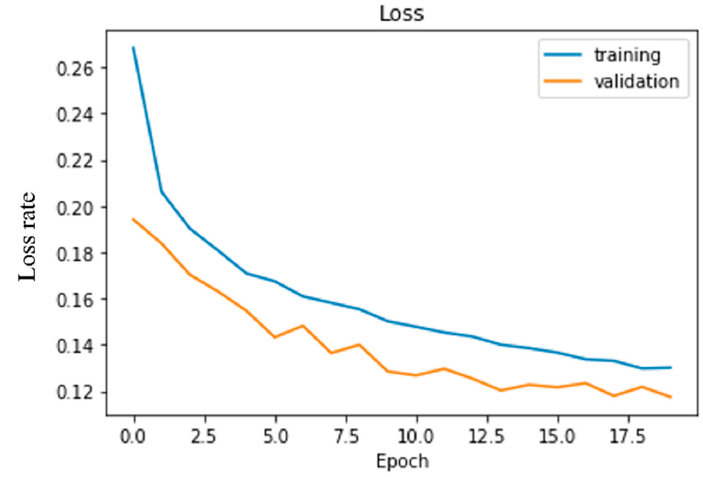
Figure 22. The loss rate of experimented CNN architecture. Table 2. Performance of the model on various environment/turn.